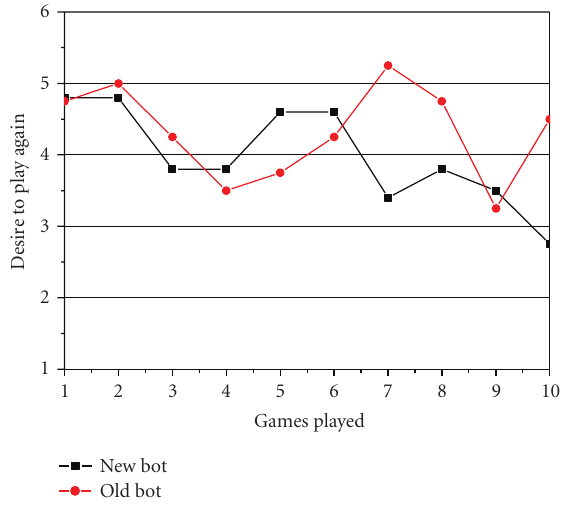
Figure 13: Comparison of survey results on the desire to play again (range from 1 = very low to 6 = very high) after each played game. Introversions bot is shown in red, while the new bot is shown in